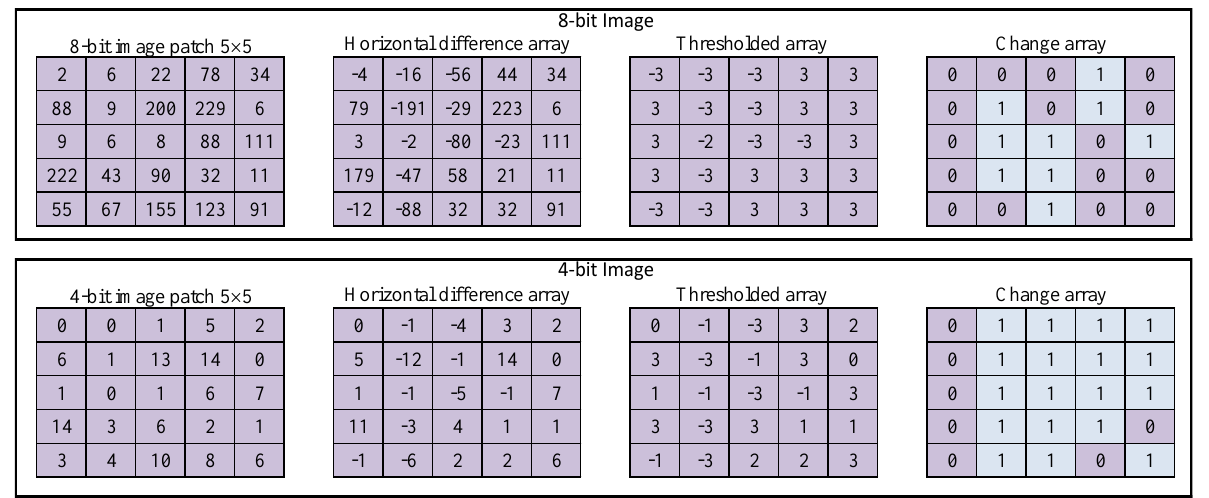
Figure 4. The 8-bit and 4-bit depth image statistical analysis.